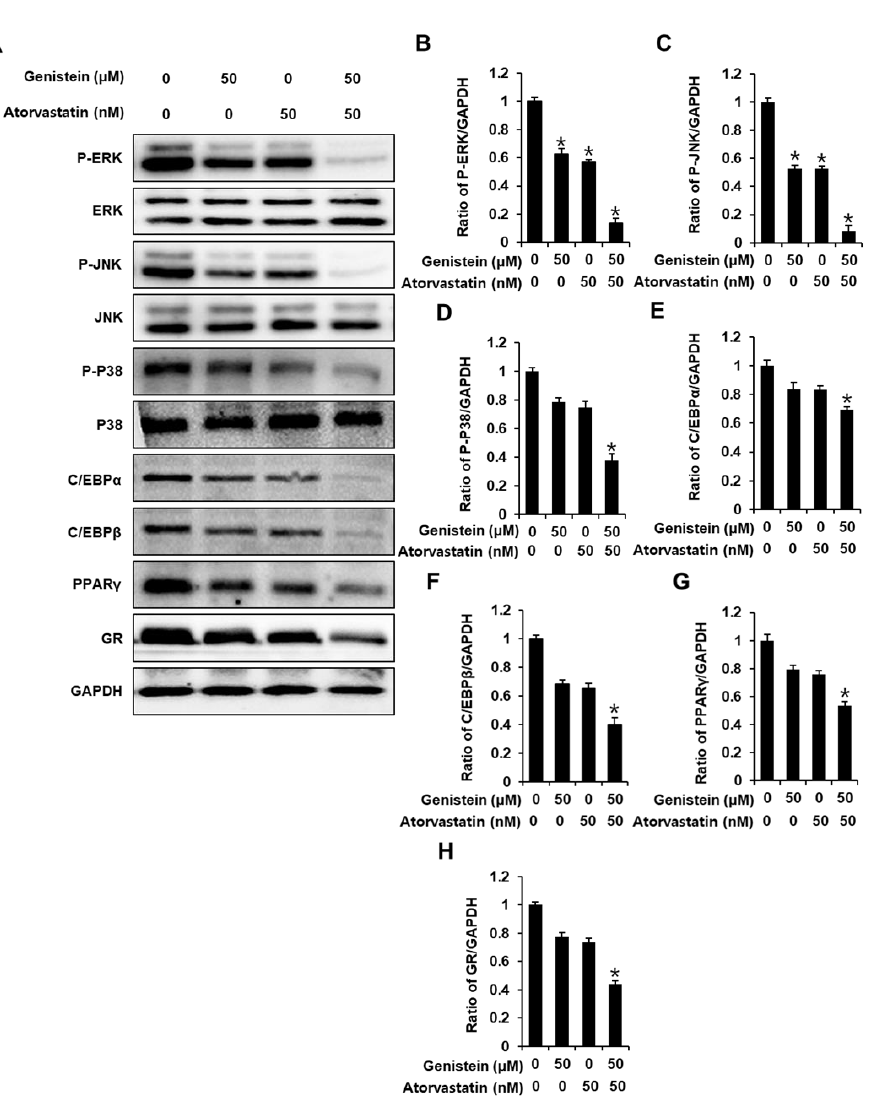
Figure 2. Inhibitory effects of genistein and atorvastatin on the expression of proteins involved in adipogenesis in differentiated 3T3L-1 cells. ( A ) The protein expression of phospho-extracellular signal-regulated kinase (P-ERK), ERK, phospho-c-Jun-N-terminal kinase (P-JNK), JNK, phospho-P38 (P-P38), P38, peroxisome proliferator-activated receptor γ (PPAR γ ), CCAAT/enhancer-binding protein alpha (C/EBP α ), C/EBP β , glucocorticoid receptor (GR), and glyceraldehyde 3-phosphate dehydrogenase (GAPDH) in differentiated 3T3L-1 cells on day 8 after treatment with genistein and/or atorvastatin. ( B – H ) Analysis of the ratios of the band intensities of P-ERK, P-JNK, P-P38, PPAR γ , C/EBP α , C/EBP β , and GR compared with differentiated 3T3L-1 cells without treatment (n = 3